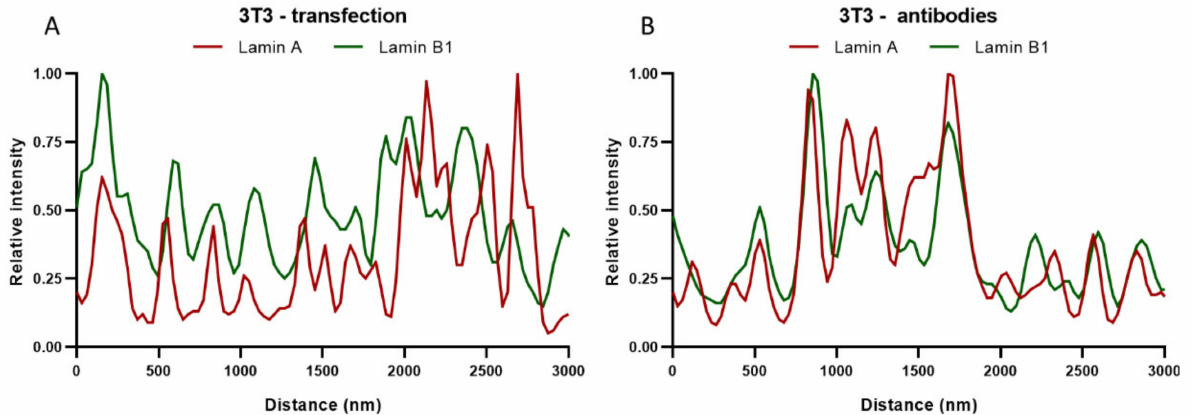
Figure 7. Plot profiles of lamins’ intensities in STED microscopy images, normalized to maximum value. Red curves show the relative intensity of lamin A, green curves the relative intensity of lamin B1. ( A ) 3T3 transfected with lamin-A-YFP and lamin-B1-EGFP. ( B ) 3T3 stained with antibodies against lamin A and